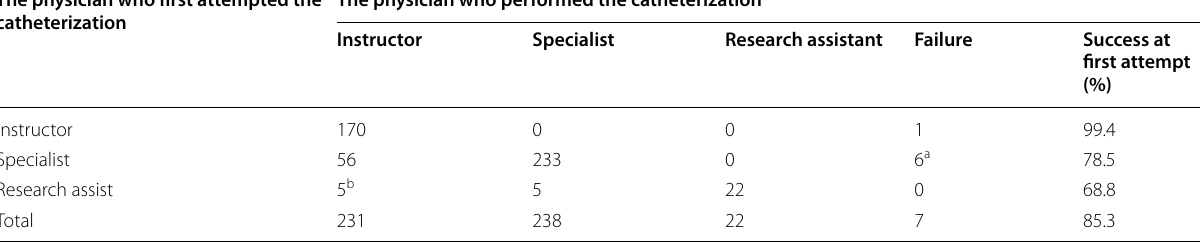
Abbreviations : Assist Assistant a Three catheterization attempts made by the instructor failed b Three catheterization attempts made by the specialists failed